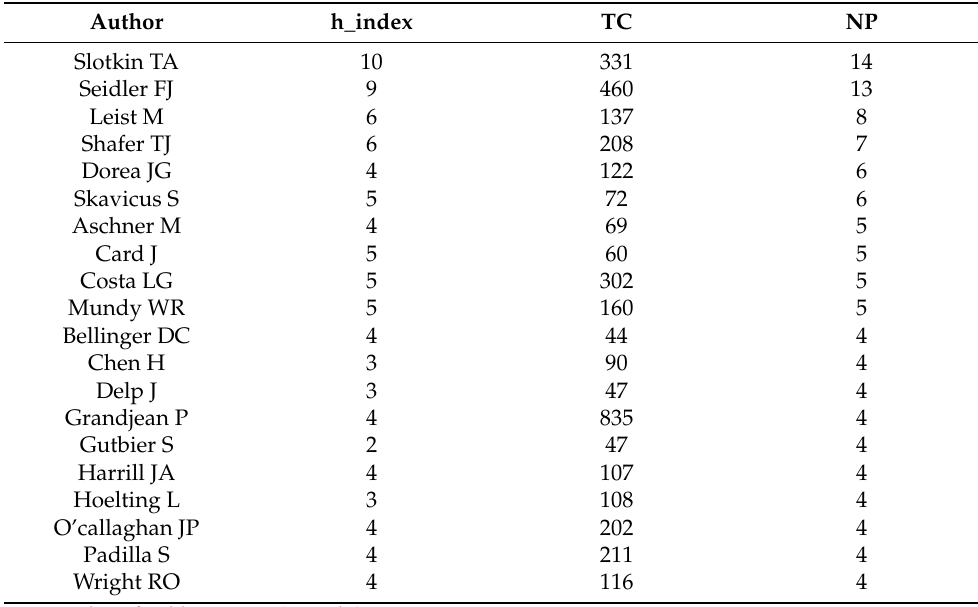
Table 2. Most relevant authors between 2011 and 2020.